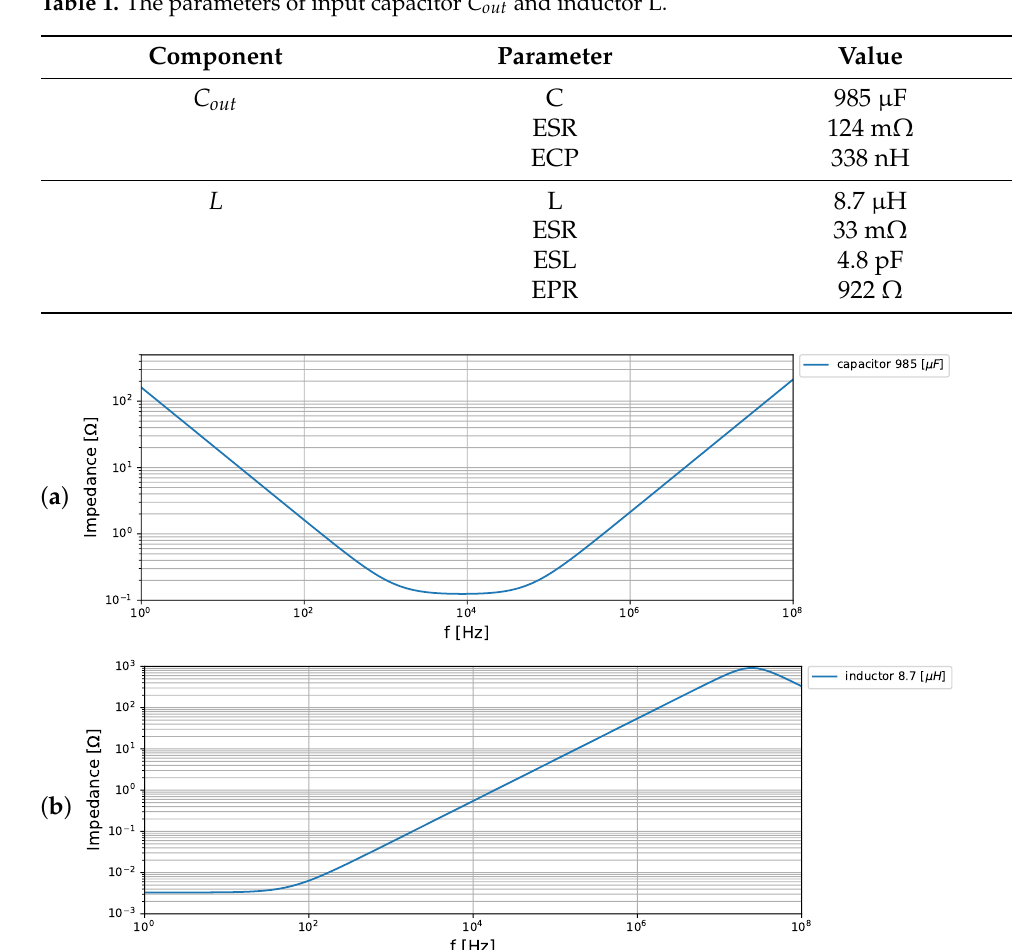
Figure 6. Passive components impedance: ( a ) capacitor C = 985 µ F and ( b ) inductor L = 8.7 µ